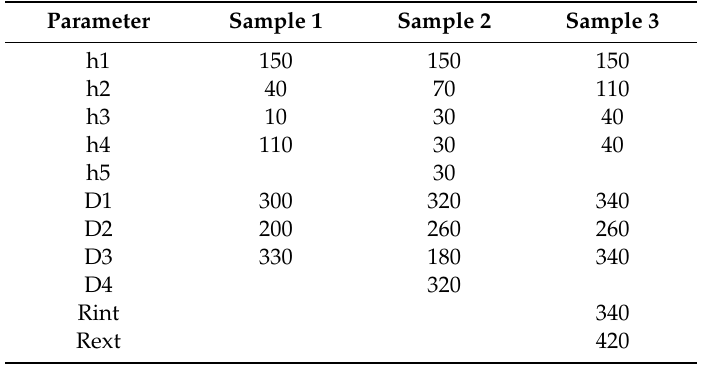
Figure B1. Sketch of ( a ) Sample 1, ( b ) Sample 2 and ( c ) Sample 3 as modelled in the Lumerical FDTD solution software. In each figure the blue shape represents the pillar, the yellow part models the gold while the white region is air. The values of the structures dimensions are reported in Table A1. Table A1. Values of the model parameters for the three samples sketched in Figure B1.